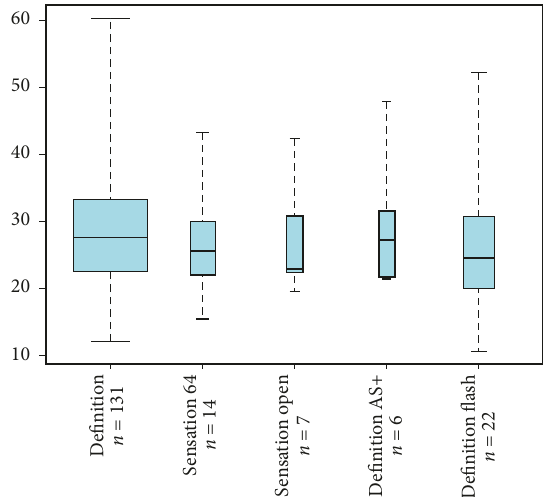
Figure 3: EDs [in mSv] from triphasic CTA scans performed on the 5 scanner types employed most frequently.